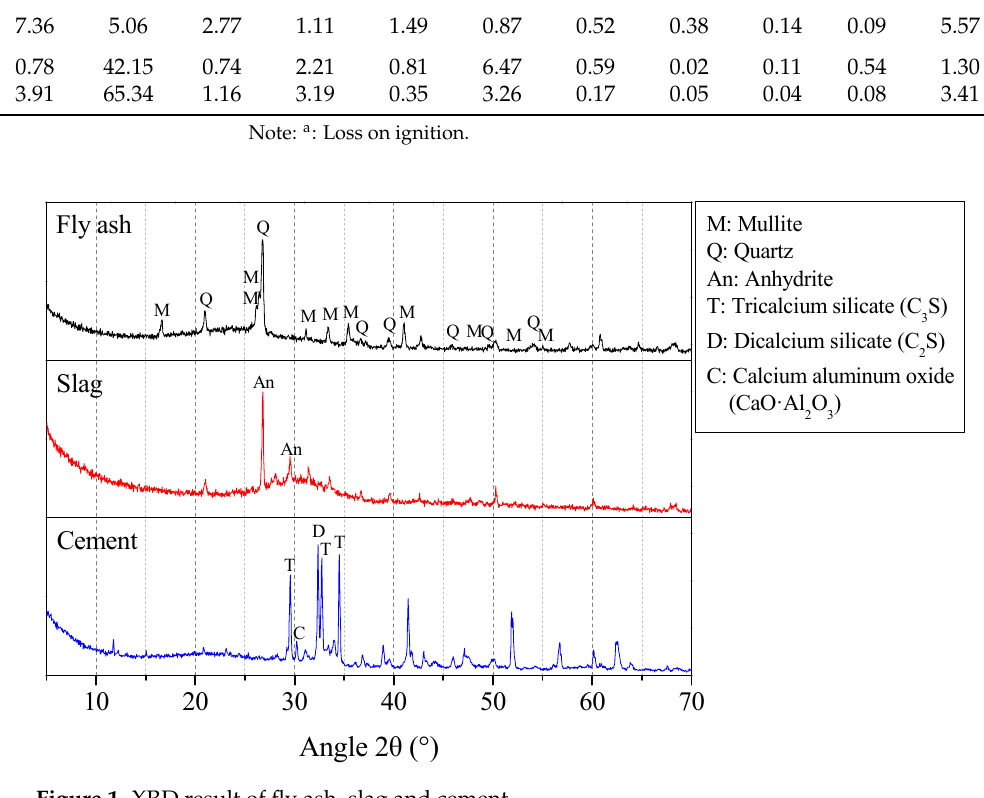
Figure 1. XRD result of fly ash, slag and cement.